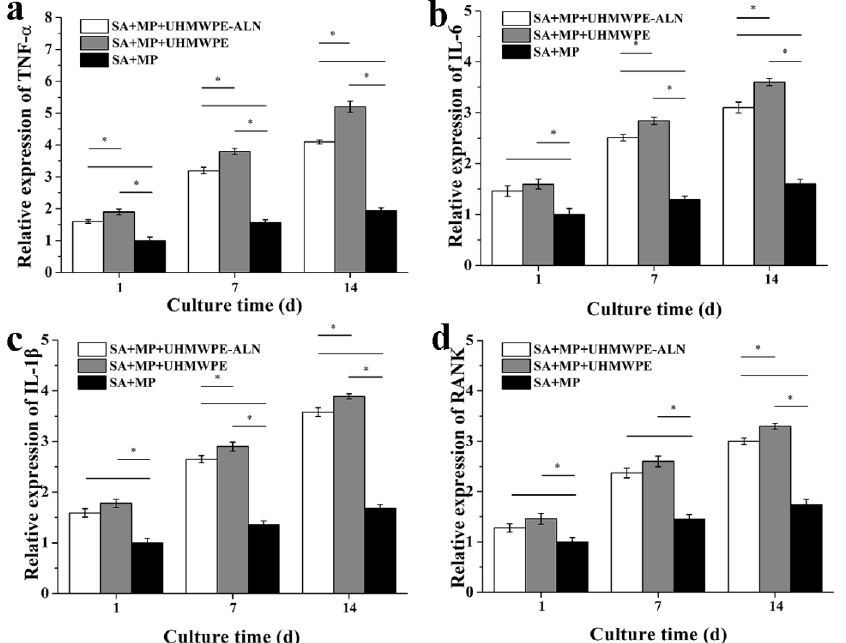
Figure 5. Relative gene expressions of TNF- α ( a ), IL-6 ( b ), IL- 1β ( c ), and RANK ( d ) of macrophages after being co-cultured with critical-sized UHMWPE-ALN wear particles in cell reactors for 1, 7, and 14 d by RT-PCR analysis ( n = 3, * p <